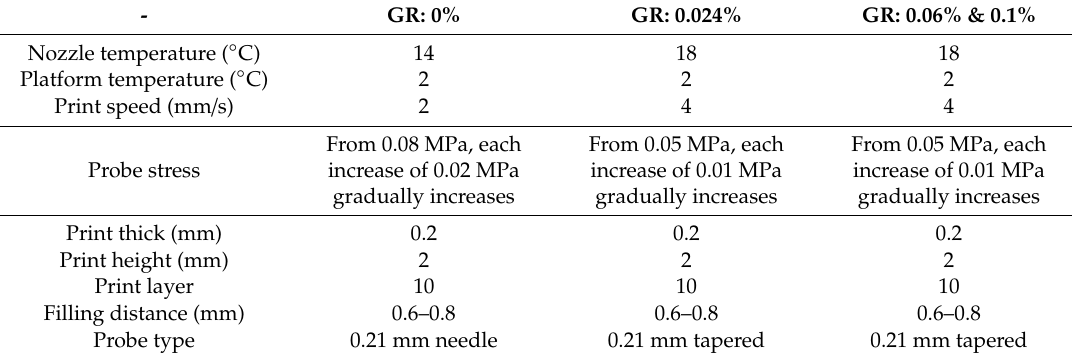
Table 2. Print parameter conditions for various ratios of